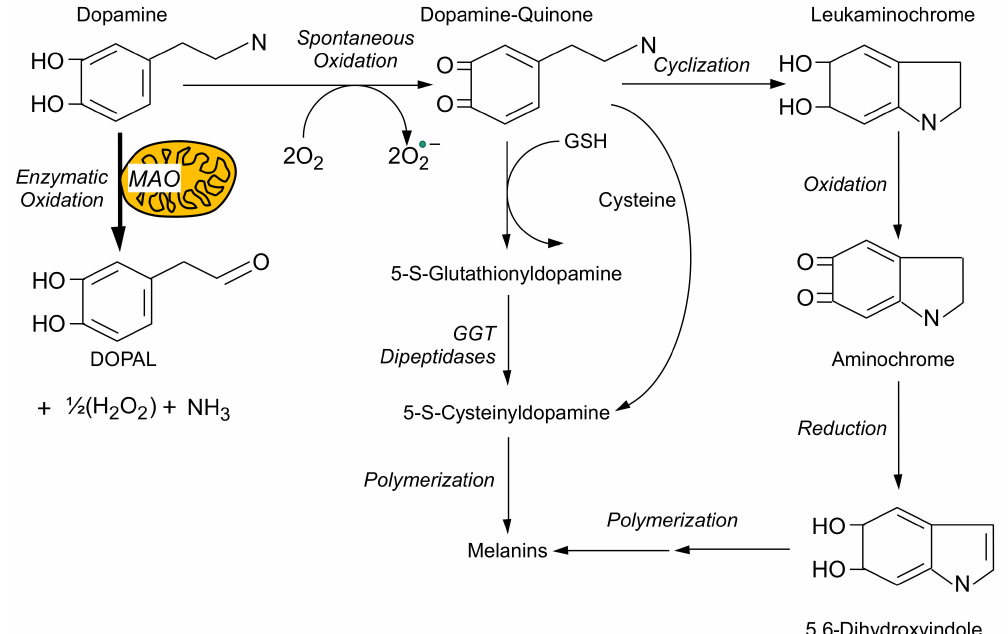
Figure 1. Enzymatic and spontaneous oxidation of dopamine. Monoamine oxidase (MAO) in the outer mitochondrial membrane converts dopamine to 3,4-dihydroxyphenylacetaldehyde (DOPAL), ammonia, and hydrogen peroxide. Dopamine oxidizes spontaneously to dopamine quinone, generating superoxide radical. Dopamine quinone can react SH) to form glutathionyldopamine, which, in the presence of gammaglutamyl transferase (GGT) and dipeptidases, results in the formation of 5-S-cysteinyldopamine (Cys-DA). Cys-DA can also be produced by dopamine quinone reacting with cysteine. Cyclization of dopamine quinone produces leukaminochrome, which can be oxidized to form aminochrome. Reduction of aminochrome yields the indole 5,6-dihydroxyindole. Melanins are formed from polymerization of Cys-DA or 5,6- dihydroxyindole. The relatively thick arrow corresponding to MAO is used to denote that given the alternative spontaneous vs. enzyme-catalyzed oxidation of cytoplasmic dopamine, the enzymatic route would predominate; however, MAO inhibition could increase the formation of spontaneous oxidation